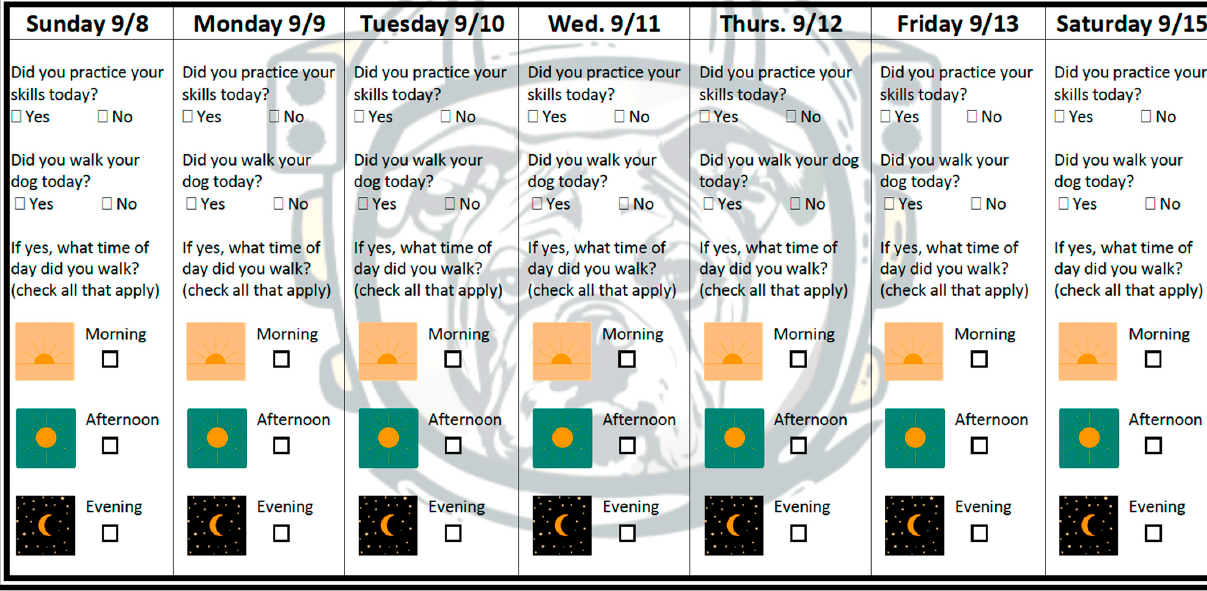
Figure 1. Study tracking sheet.